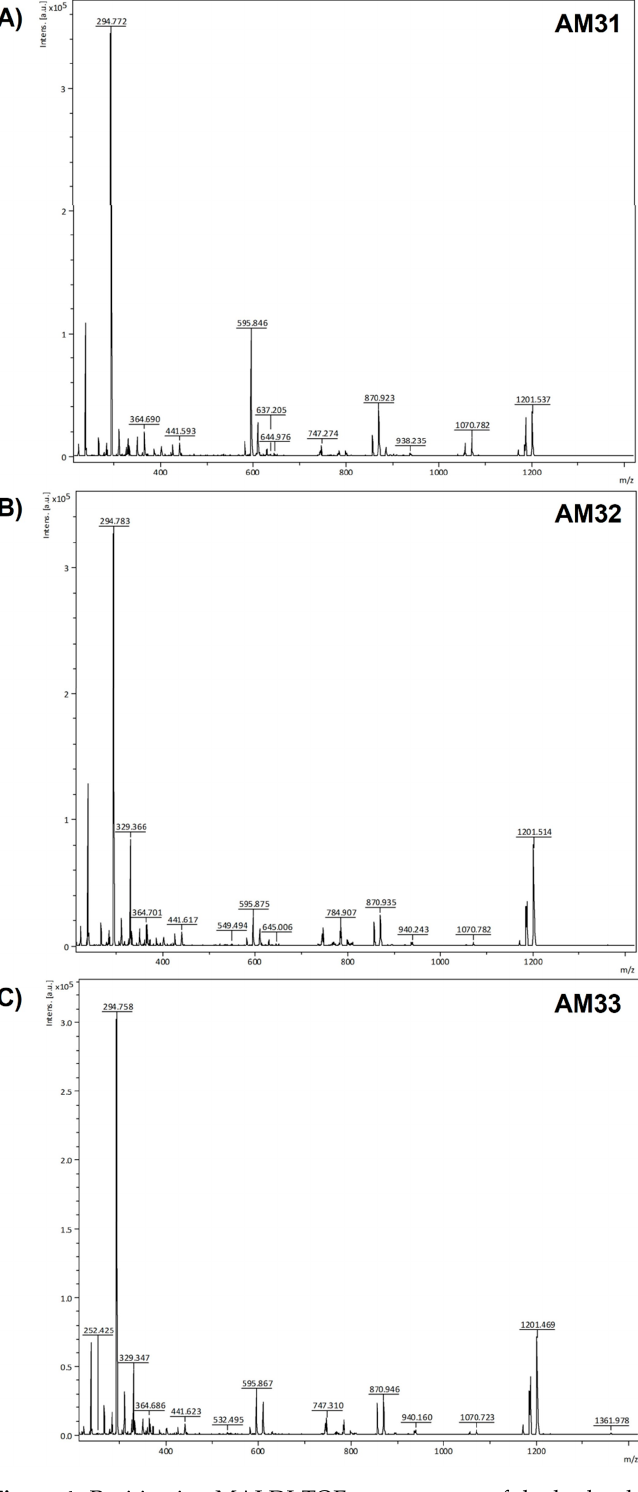
Figure 4. Positive ion MALDI-TOF mass spectra of the hydroalcoholic shoot extracts of the three clonal lines in reflectron mode. ( A ) AM31, ( B ) AM32, and ( C ) AM33. The concentration of each extract was adjusted to 10 mg/mL. The ion fragments at m / z 254.425 and 294.758 correpond to DHB matrix [M+H] + and [M+K+] +